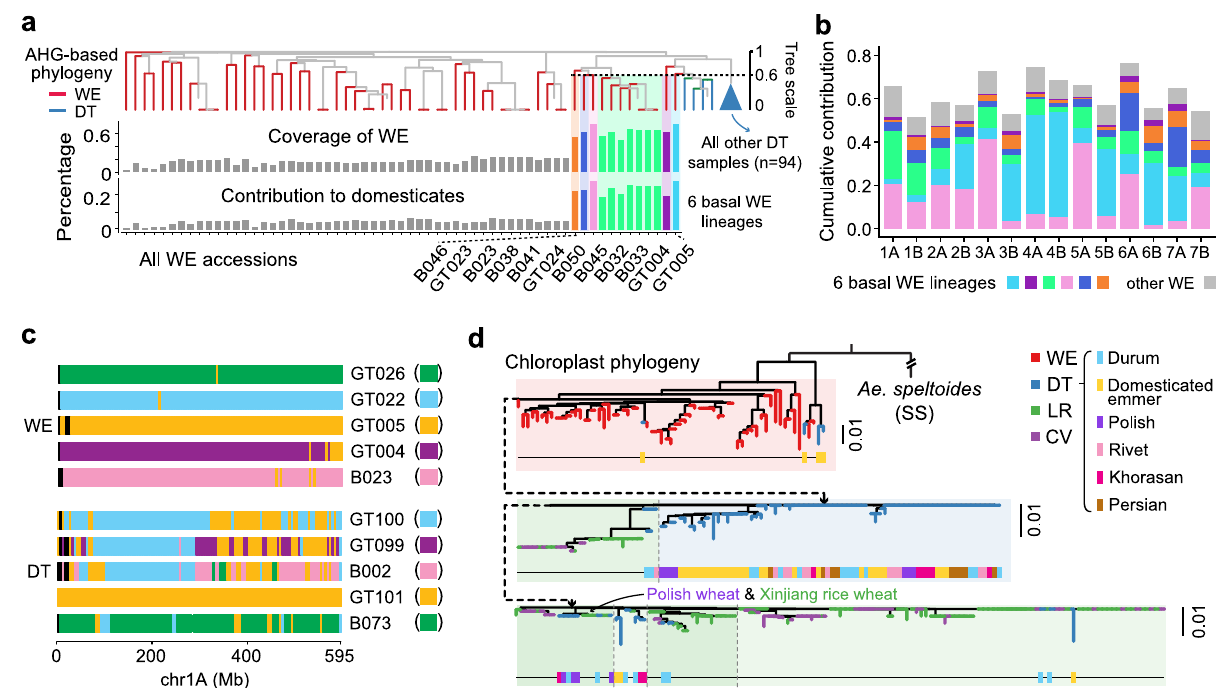
Fig. 3 Tracing the basal lineages for wheat domestication. a NJ tree of WE and DT accessions constructed with AHG-based distances for the A&B subgenomes. The six basal lineages are noted by colored areas, and branches of DT accessions are collapsed. The percentage of AHGs in domesticated wheat gene pools that were found in each WE accession (contribution) and the genomic proportion of each WE accession that contributed AHGs to domesticated wheat gene pools (coverage) is shown. 6 basal lineages, consisted of 12 accessions, are highlighted. b Cumulative contribution of 6 WE founder lineages and other WE accessions to the domesticated wheat genetic pools is shown for individual chromosomes. c Mosaic graphs of AHGs for 5 WE and 5 DT accessions across chromosome 1 A. d Chloroplast SNP based NJ-tree provides cytoplasmic evidence for the origin of wheat. The tree is rooted by assigning Ae. speltoides (SS) accessions as an outgroup. Main clades are separated by gray dash lines. Clades containing T. polonicum (Polish wheat, tetraploid) and T. petropavlovskyi (Xinjiang wheat, hexaploid) were labeled, consistent with reported genomic introgression among the two populations 28 . Source data are provided as a Source Data fi